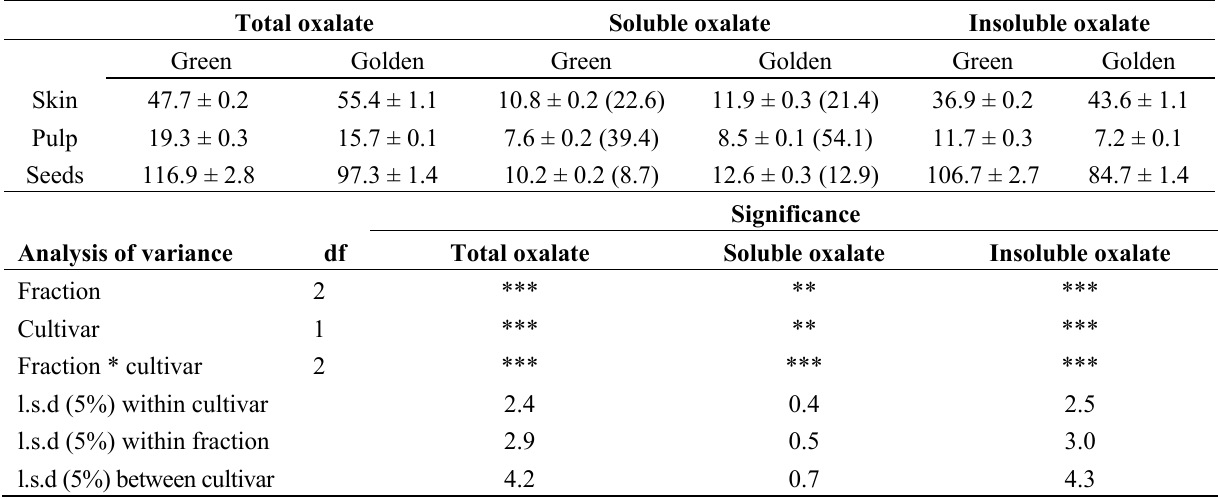
Table 2. Mean total, soluble and insoluble oxalate contents (mg/100 g FW ± SE) of the skin, pulp and seed fractions of ripe, ready to eat green and golden kiwifruit, the values in parenthesis are the ratio of soluble to total oxalate for each cultivar ( n =